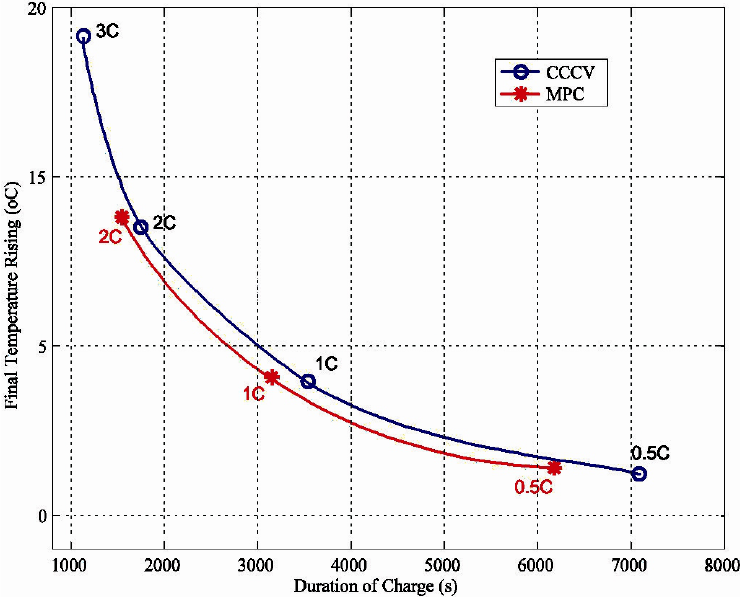
Figure 10. Pareto fronts of CCCV and MPC charging methods in experiments. The expected trajectories of MPC are modified from CCCV by multiplying by 1.10.